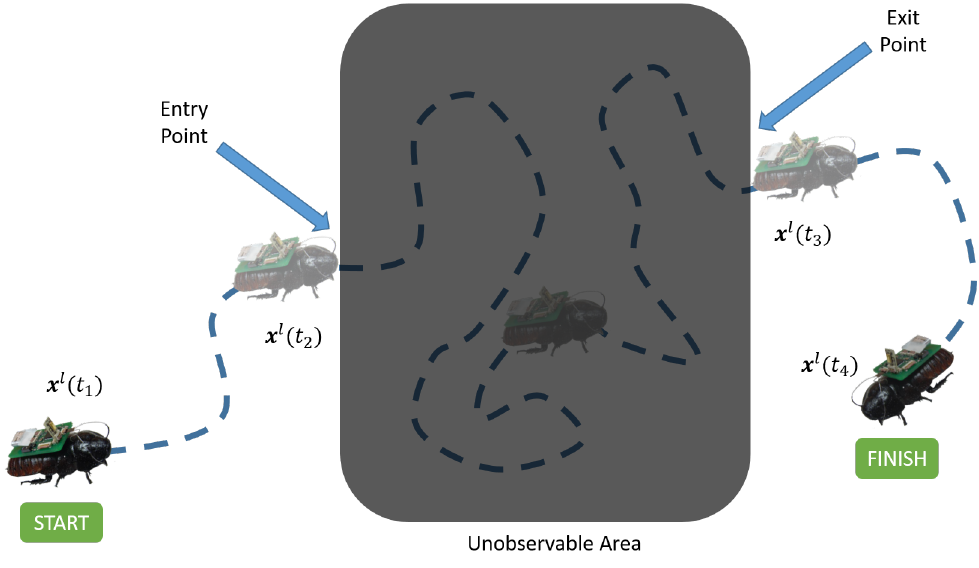
Figure 2. Problem Description: Suppose we want to track the trajectory of an agent over time. The agent can be observed during the time intervals [ t 1 , t 2 ] and [ t 3 , t 4 ] ; however, the agent is not observable during the time interval ( t 2 , t 3 ) . As such, the agent’s state is unknown during this time interval. The goal of our algorithm is to estimate the agent’s state during the interval ( t 2 , t 3 ) so that the trajectory over the interval [ t 1 , t 4 ] can be reconstructed. See Section 3 for a description of the agent’s state, x l